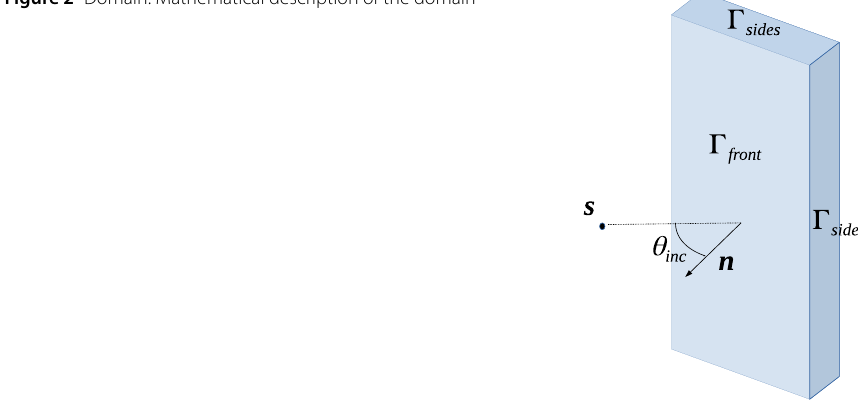
Figure 2 Domain. Mathematical description of the